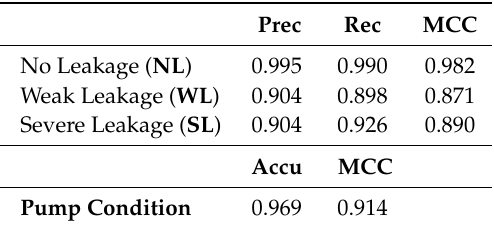
Table 6. Classification results for the Internal Pump Leakage condition at the state and multiclass classifier level.